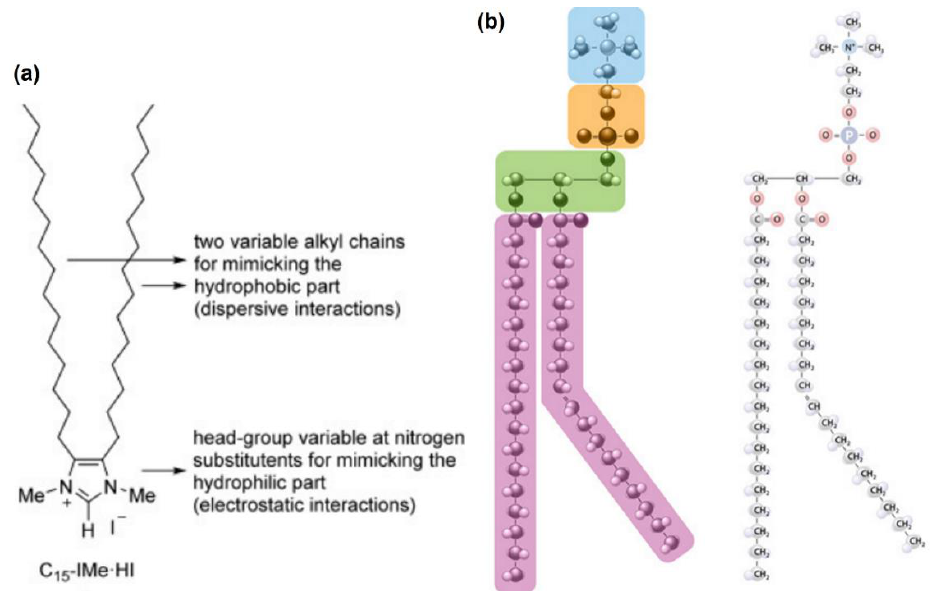
Figure 2. Sketches depicting ( a ) double-tail lipid-mimic imidazolium-based IL; ( b ) glycerol– phospholipid sub-regions with large tail lengths. The similarities are striking and allow for their ability to intercalate within the phospholipid membrane structure. Adapted with permissions from ( a ) Reference [41] John Wiley and Sons, ©2015, and ( b ) https://www.nature.com/scitable/topicpage/ cell-membranes-14052567 Nature Education